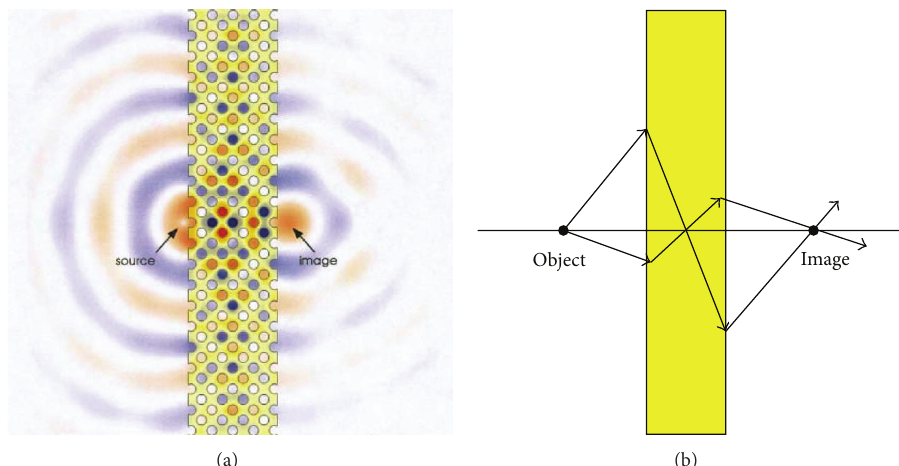
Figure 1: The light wave is originating from the left side and is getting refracted through the metallic plate and its image is on the right (this image is taken from